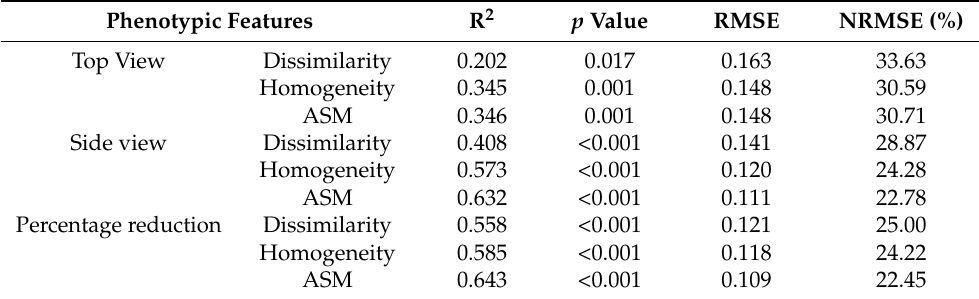
Table 9. Comparisons of CEVW evaluation using selected phenotypic features extracted from top- and side-view images under waterlogging and their percentage